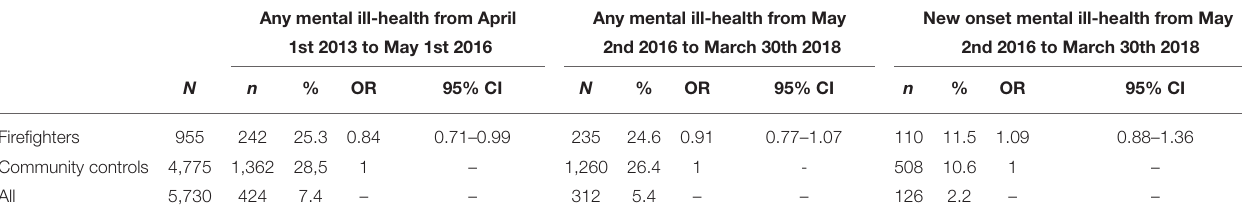
TABLE 4 | Case referent analysis of mental ill-health * as recorded in the Alberta administrative health database. Any mental ill-health from April Any mental ill-health from